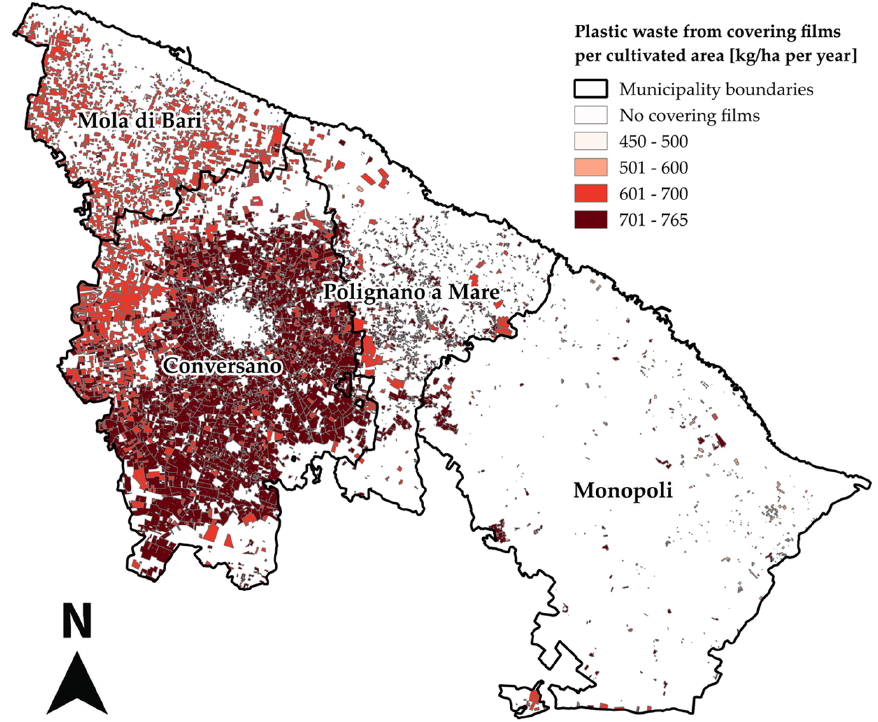
Figure 7. Distribution of the APW from covering films in the four municipalities in the actual sce- nario.